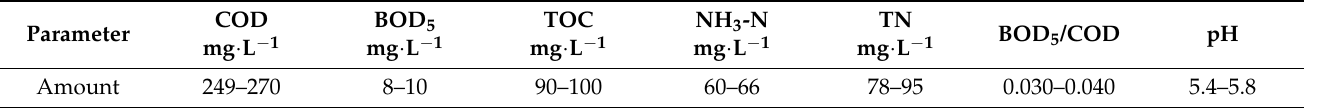
Table 1. Water quality indexes of water